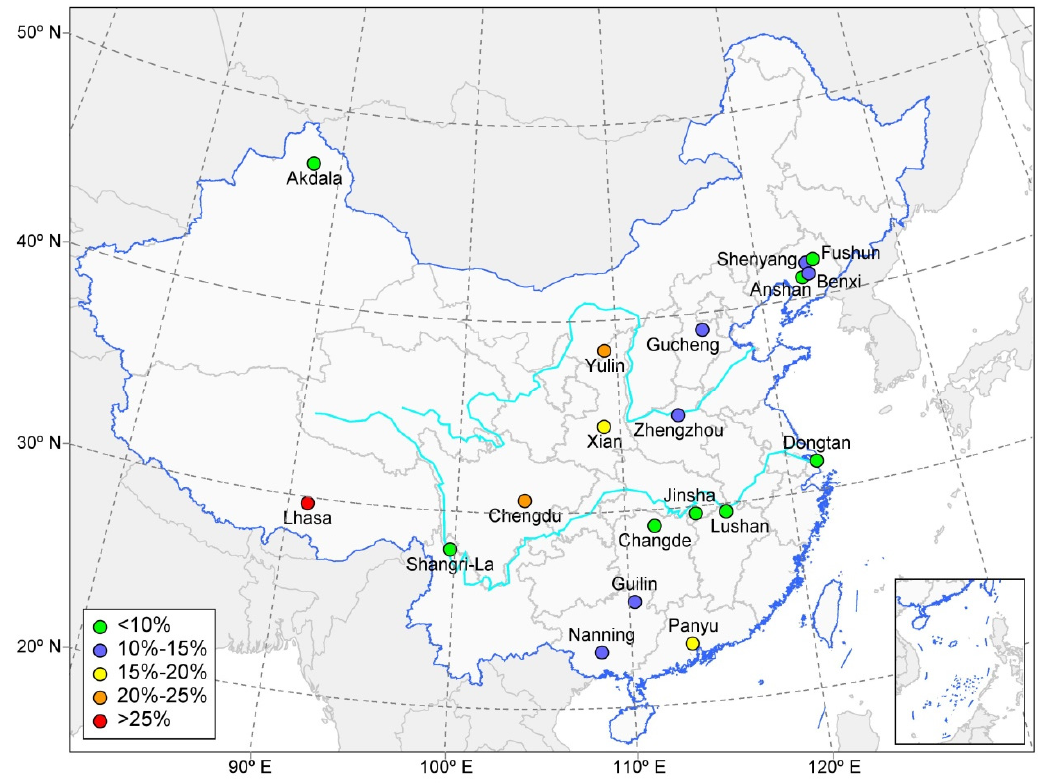
Figure 4. The average proportion of BC in PM 2.5 from 2006 to 2015.